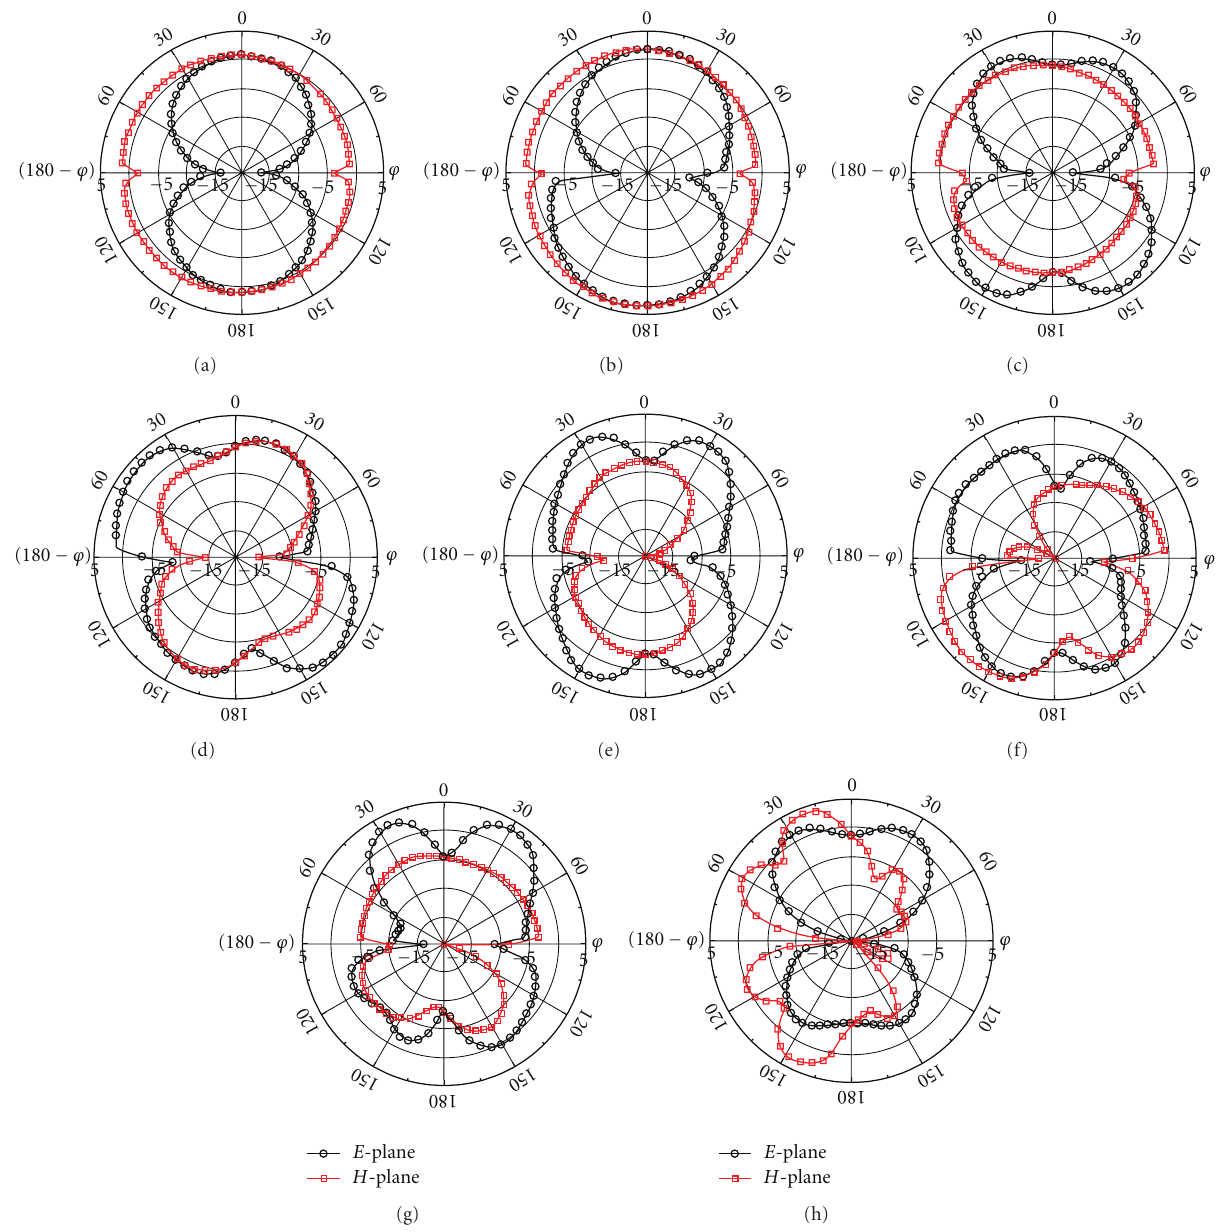
Figure 10: Simulated radiation patterns of the proposed antenna—(a) f = 1 . 95 GHz, (b) f = 2 . 5GHz, (c) f = 3 . 8 GHz, (d) f = 5 . 0 GHz, (e) f = 6 . 5 GHz, (f) f = 8 . 0 GHz, (g) f = 9 . 8GHz, and (h) f = 10 . 4